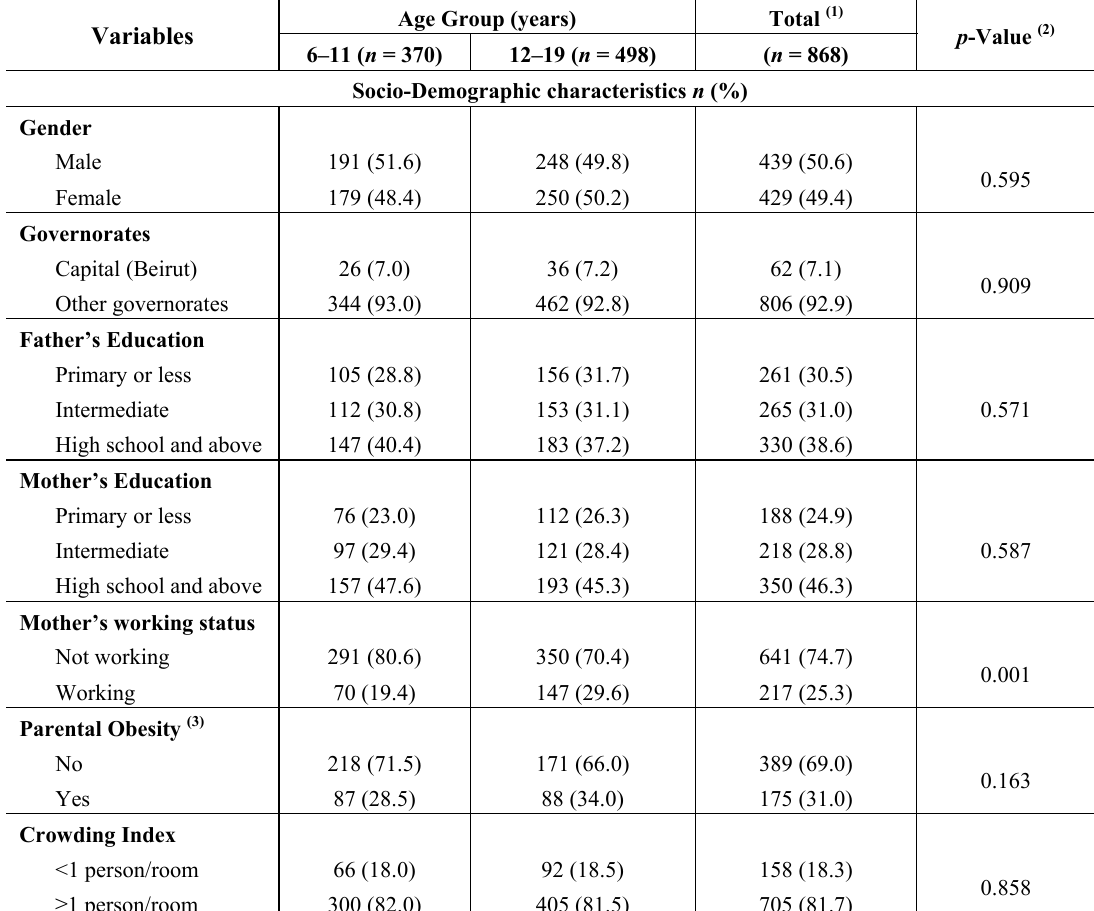
Table 1. Socio-demographic, lifestyle and anthropometric characteristics of the study sample by age group, Lebanon ( n =